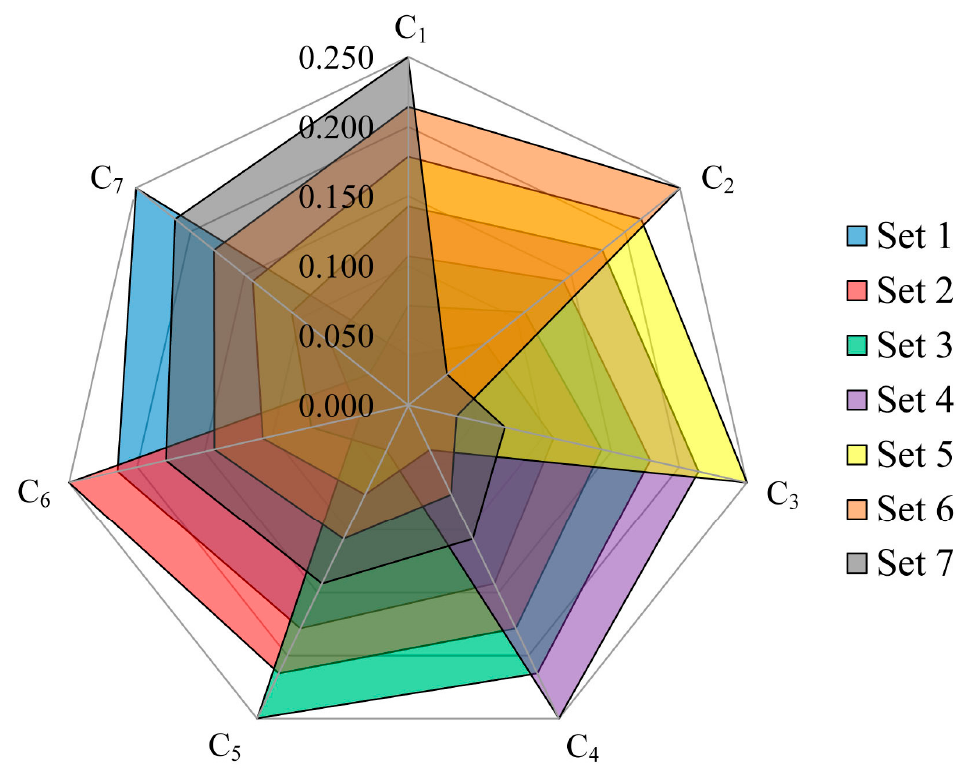
Figure 6. Graphical representation of the pattern for sensitivity analysis.